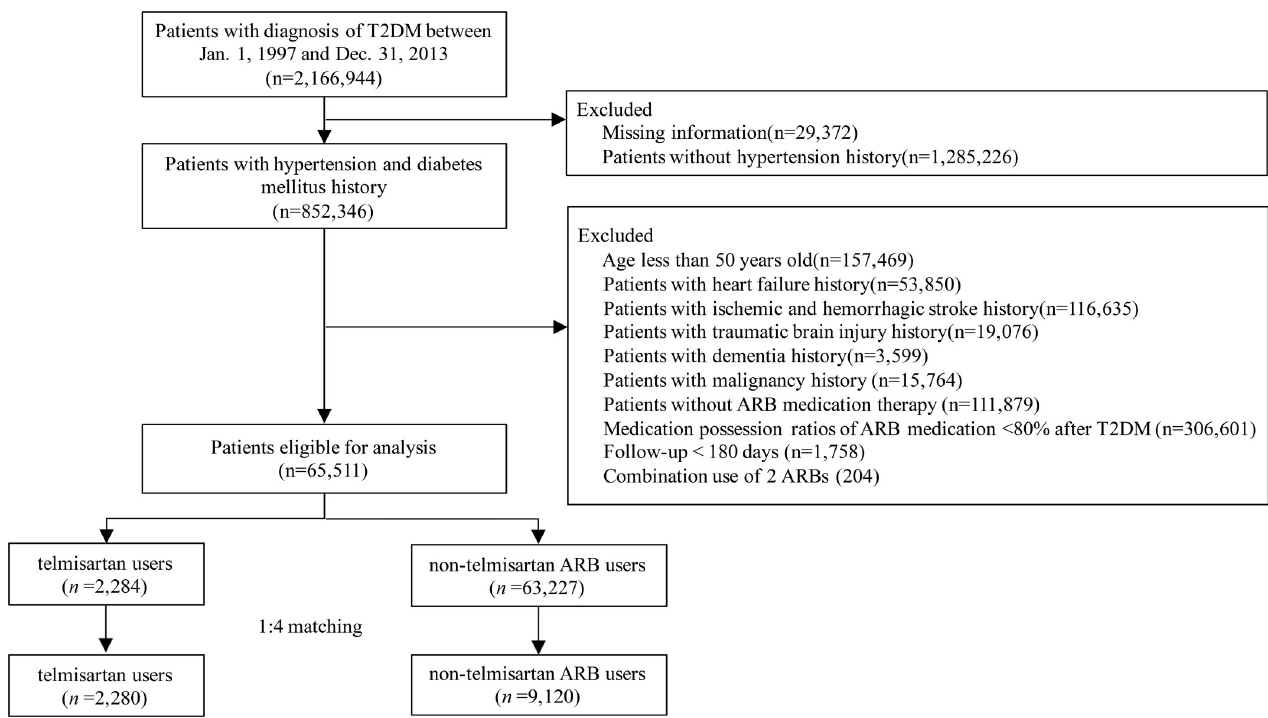
Fig 1. Flow chart for the inclusion of study patients. AU : InFig 1 ; pleasefixthegrammaticalerrorPatientswithwereeligible : Patients with hypertension and T2DM were enrolled after the relevant exclusion criteria were applied. The patients were further divided into telmisartan and non-telmisartan ARB groups according to their prescribed antihypertensive drug. ARB, angiotensin receptor blocker; T2DM, type 2 diabetes